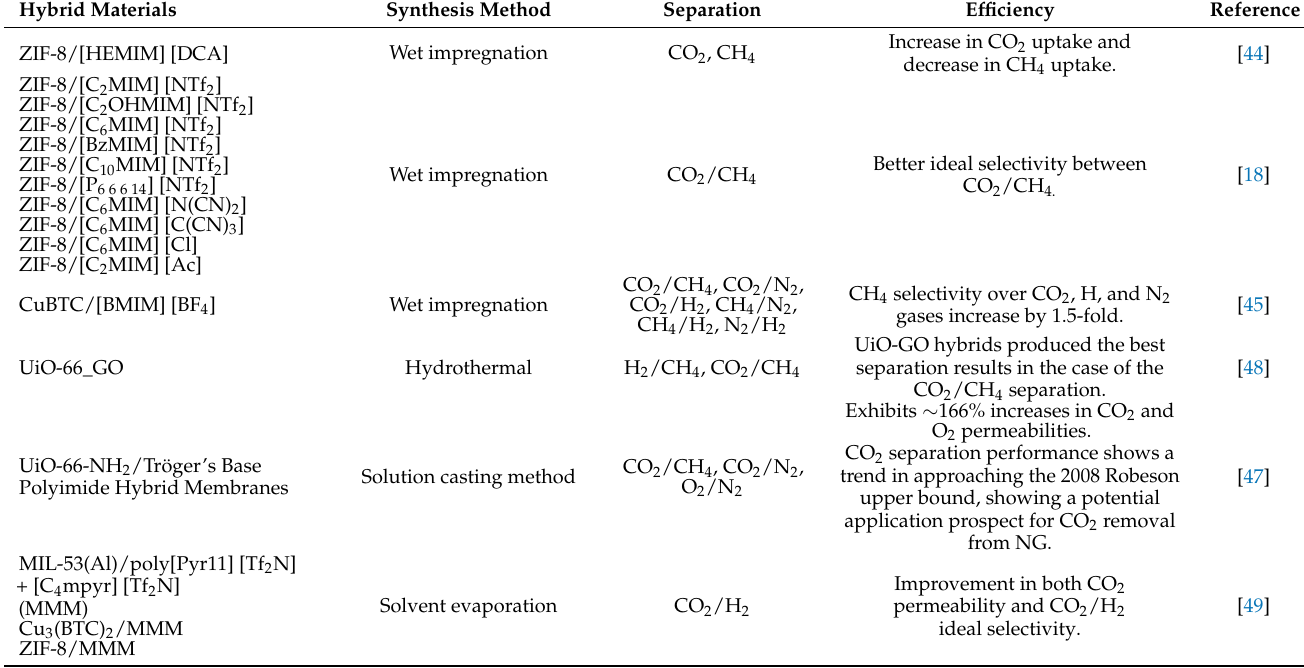
Table 1. Summary of hybrid materials for gas